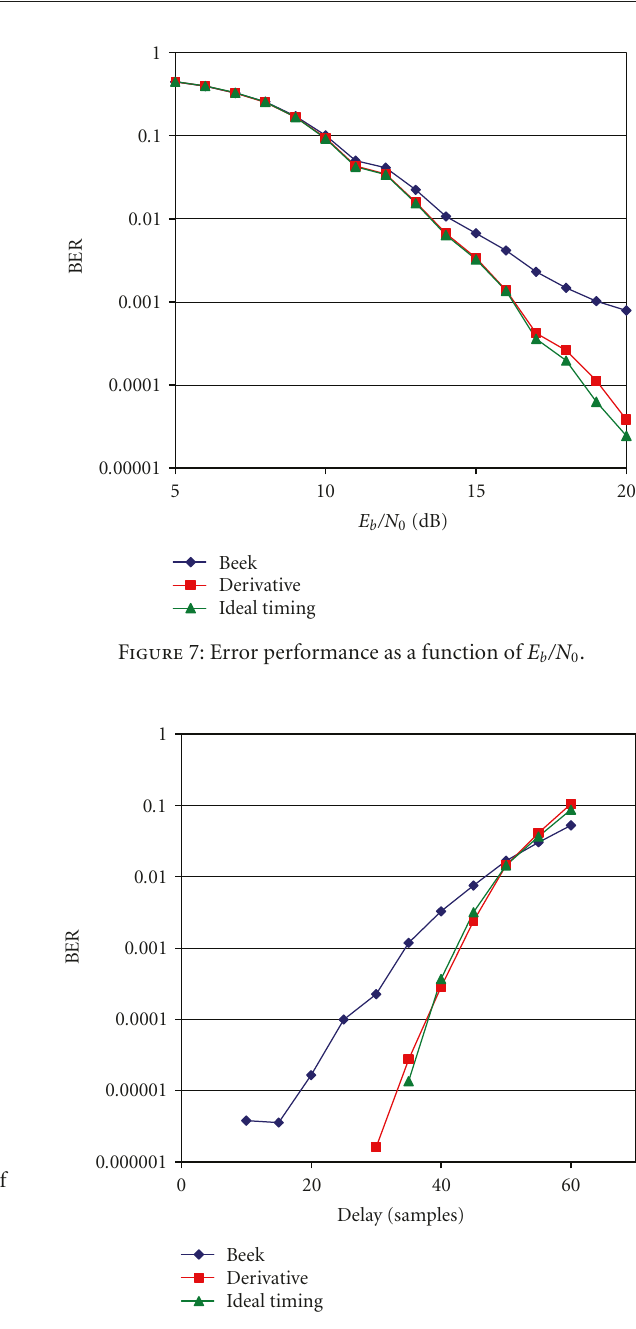
Figure 8: Error performance as a function of SFN